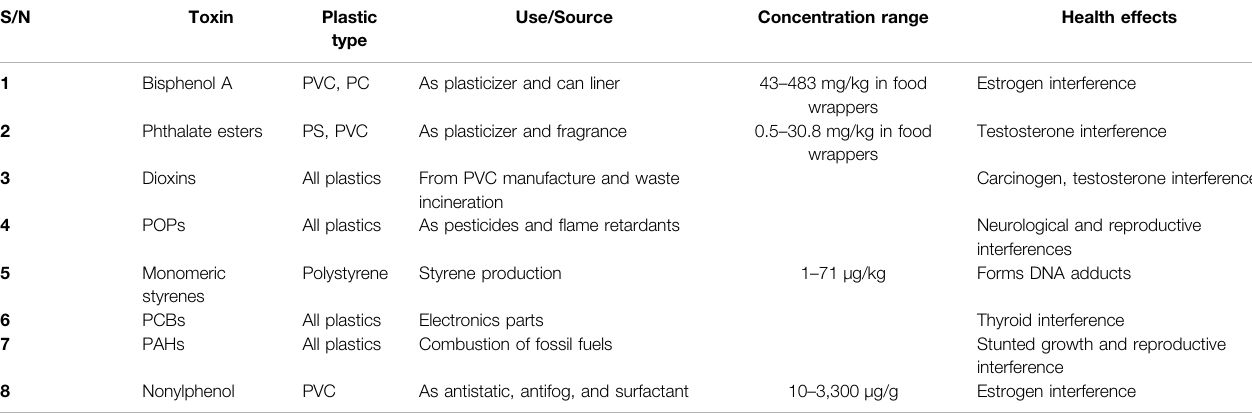
TABLE 1 | Properties of toxins found in or produced by plastics (Bouchentouf, 2013; Pawar et al., 2016).